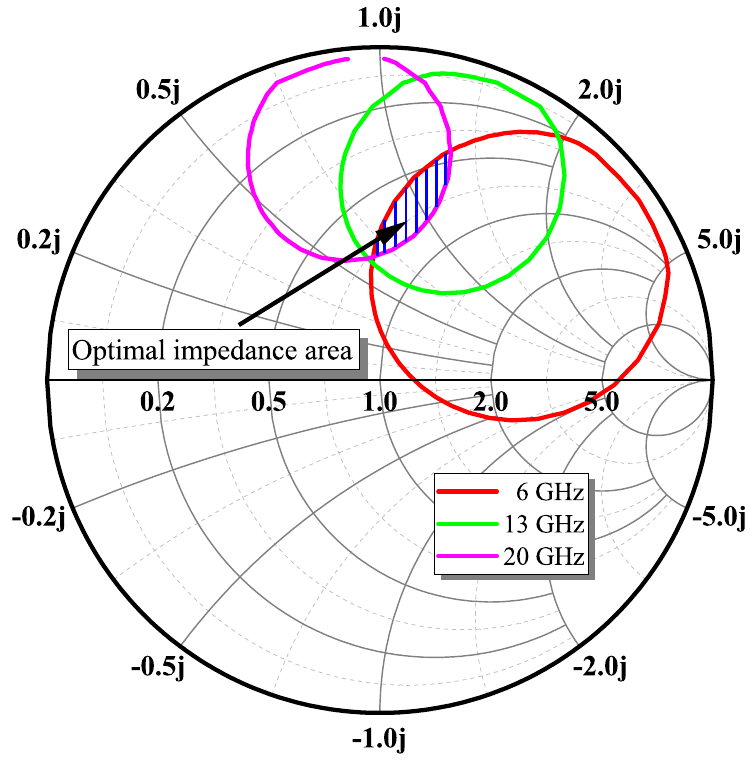
Figure 5. Optimal impedance area in power contours of different frequency. Table 1. Optimal impedance values for the first and second stage of the transistors